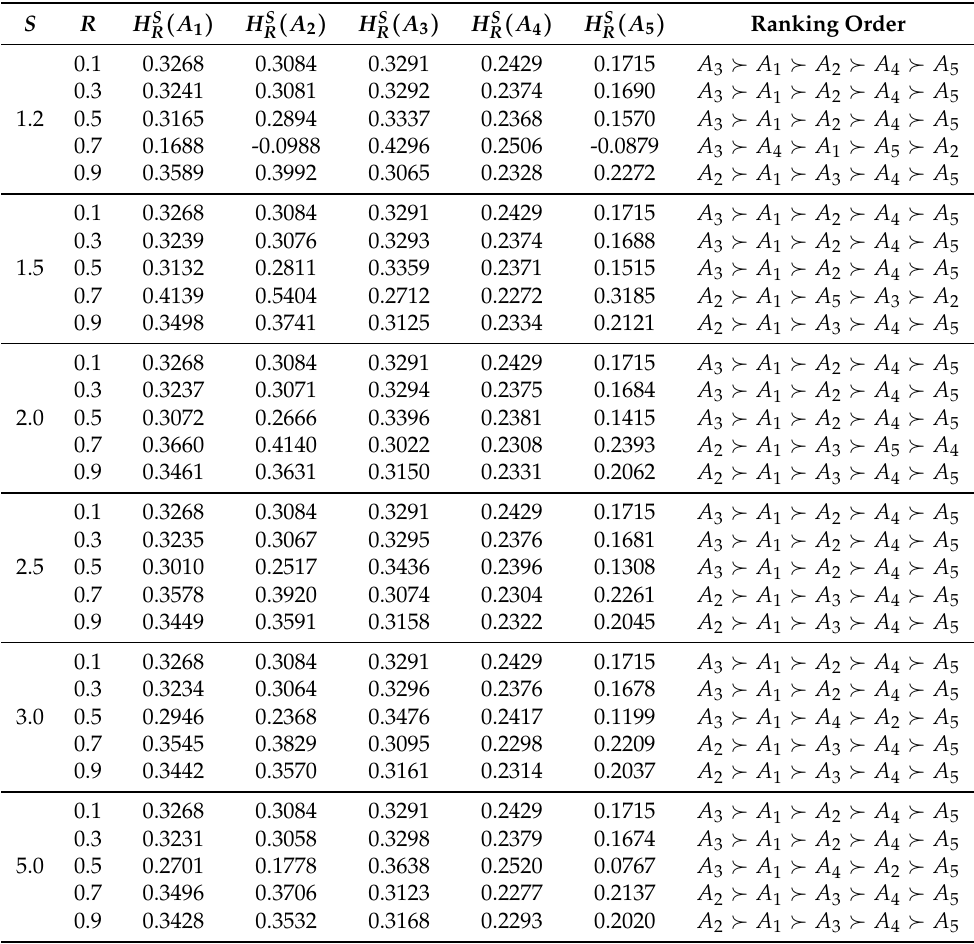
by using Approach R